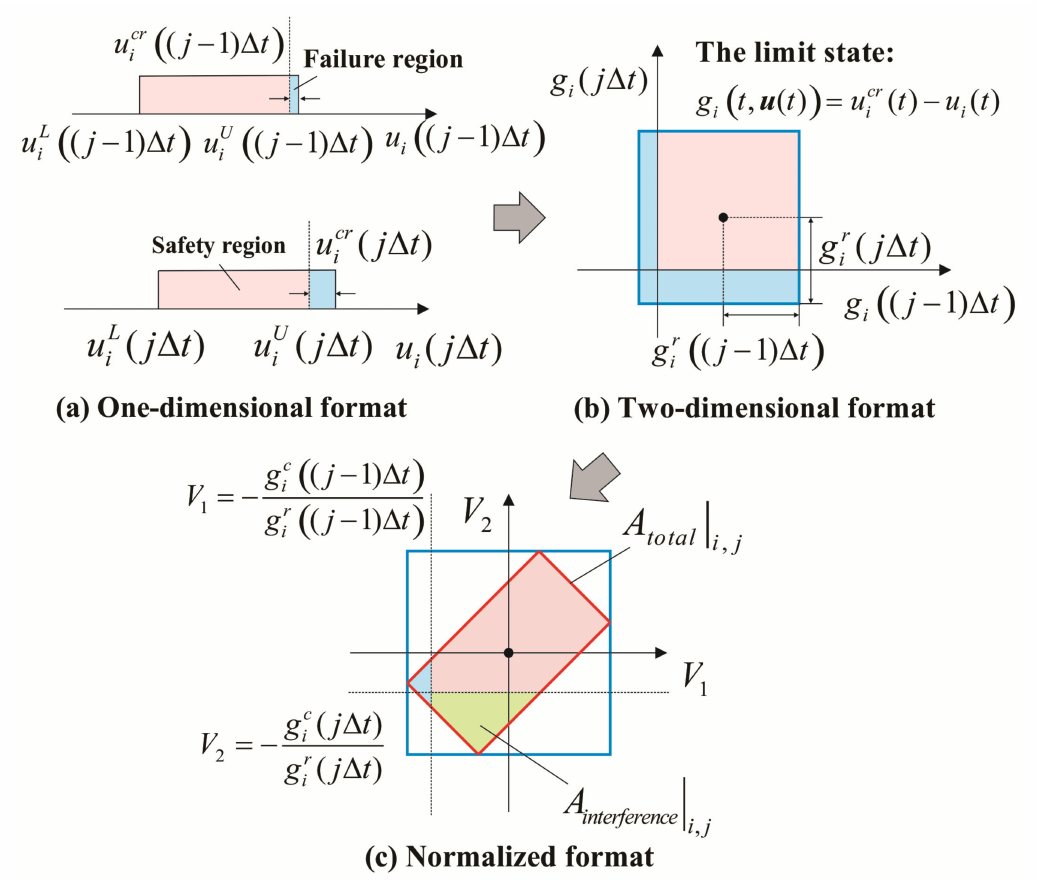
Figure 2. The diagram for calculating the possibility index of E i , j .